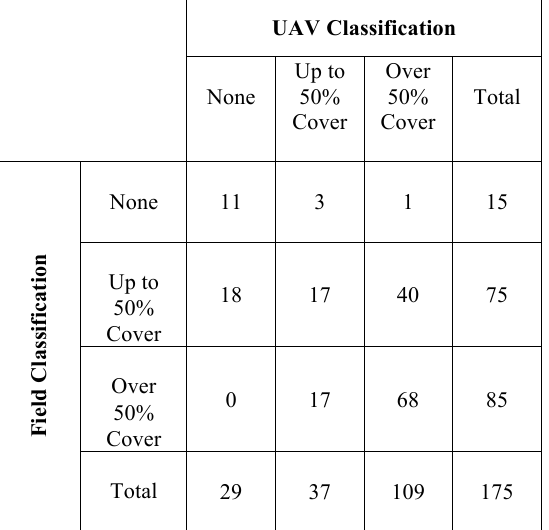
Table 6: 3 x 3 matrix comparing the UAV classifications to the field classifications for percent cover of emergent vegetation ( p < 0.001).